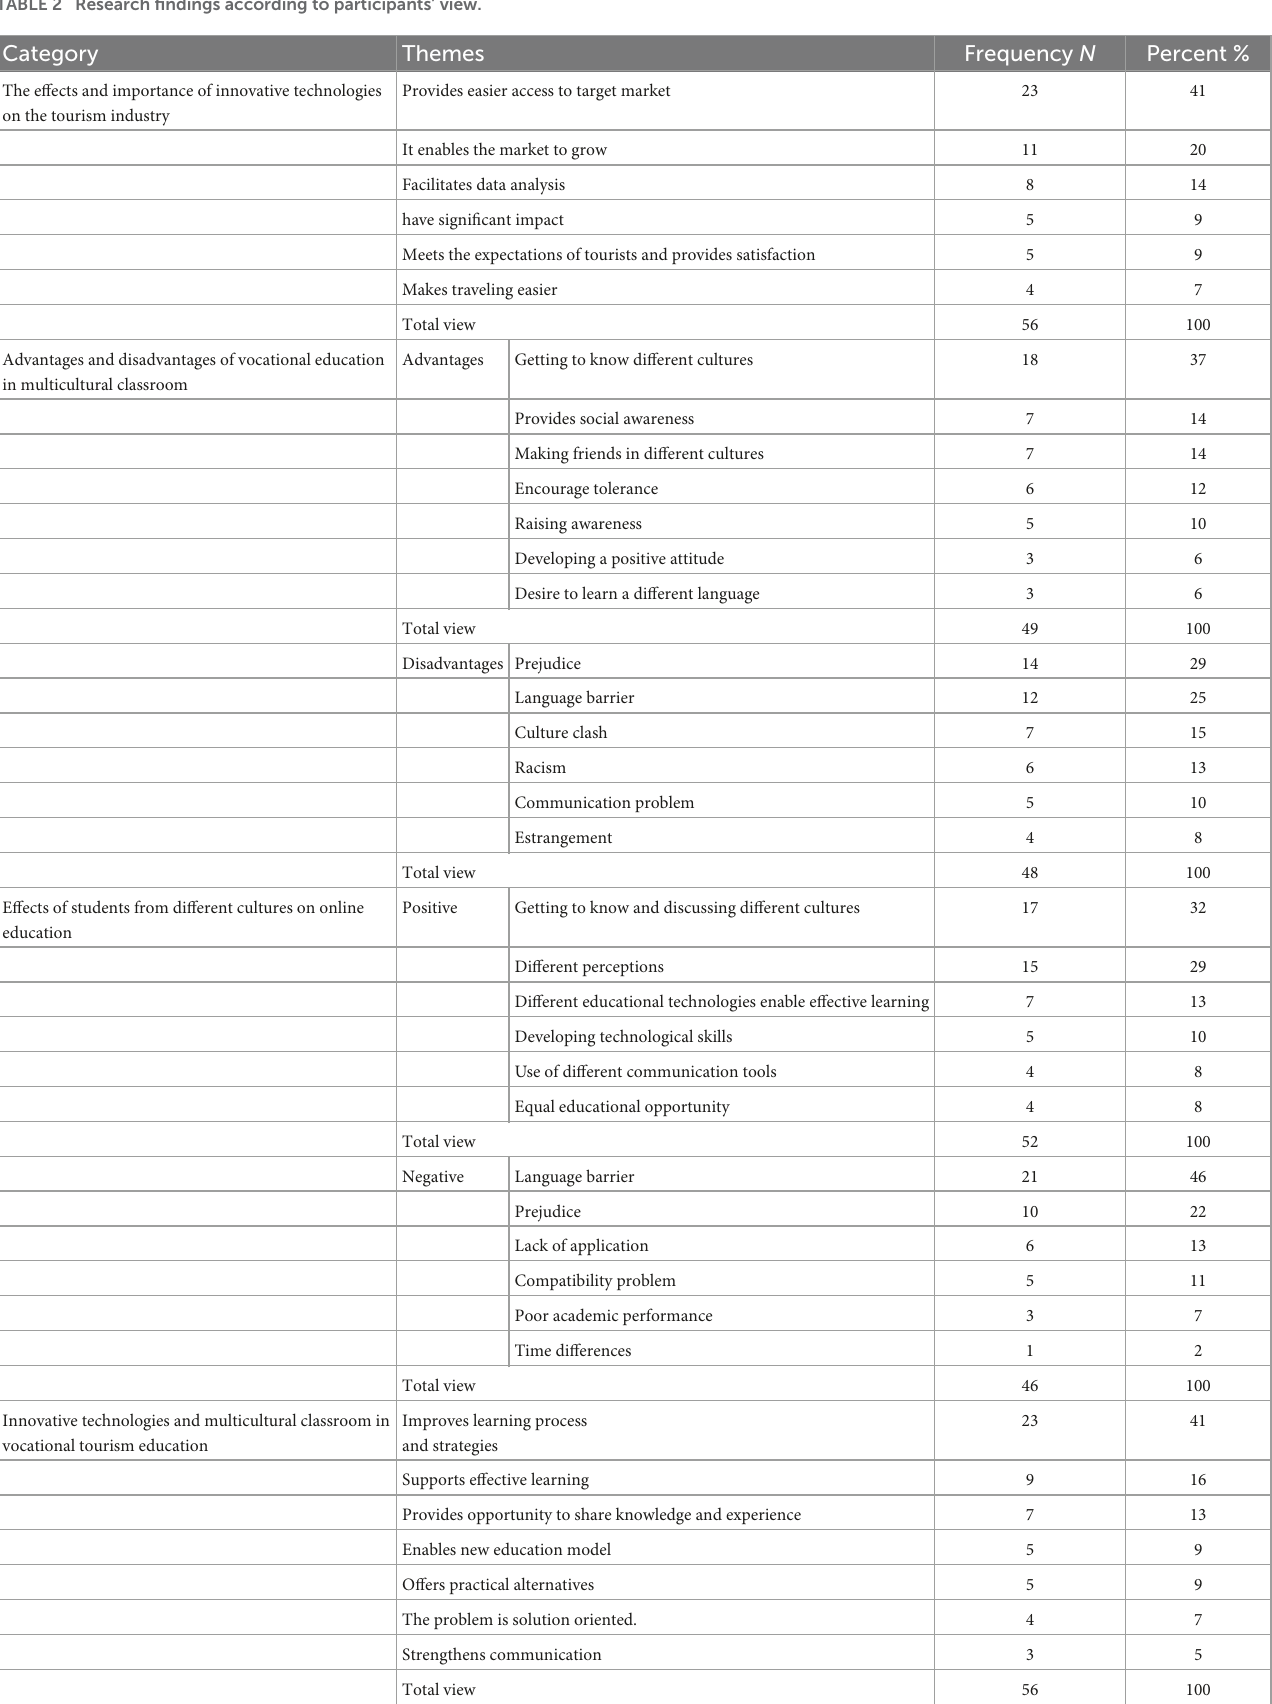
TABLE 2 Research findings according to participants’